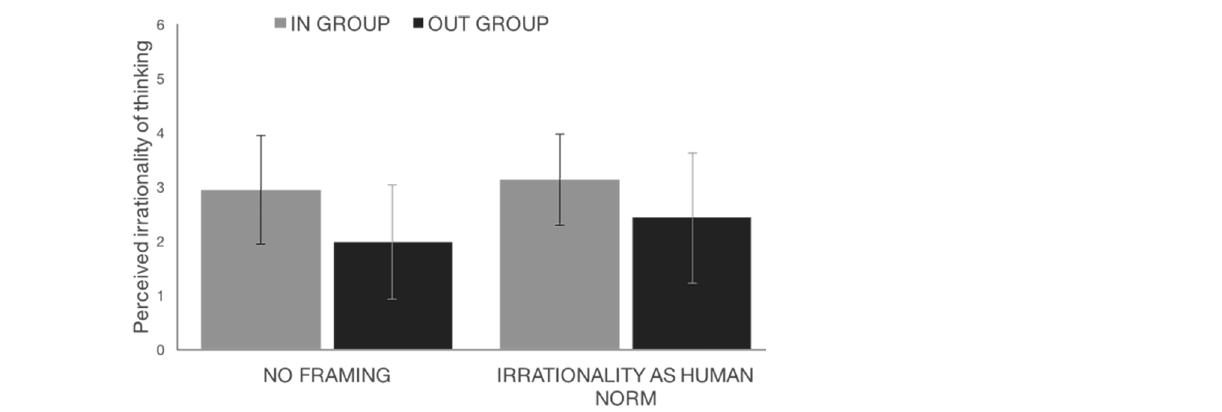
Figure 4. Evaluation of the target person in no framing and irrationality as human trait conditions as a function of the target person’s membership, the Swedish sample in Study 2. Note. Error bars represent standard deviations ( SD